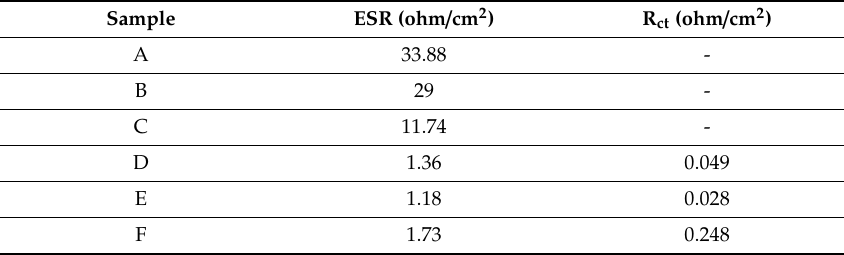
Figure 12. Nyquist plot for samples (A, B and C). Table 5. The ESR and R ct values for di ff erent samples.